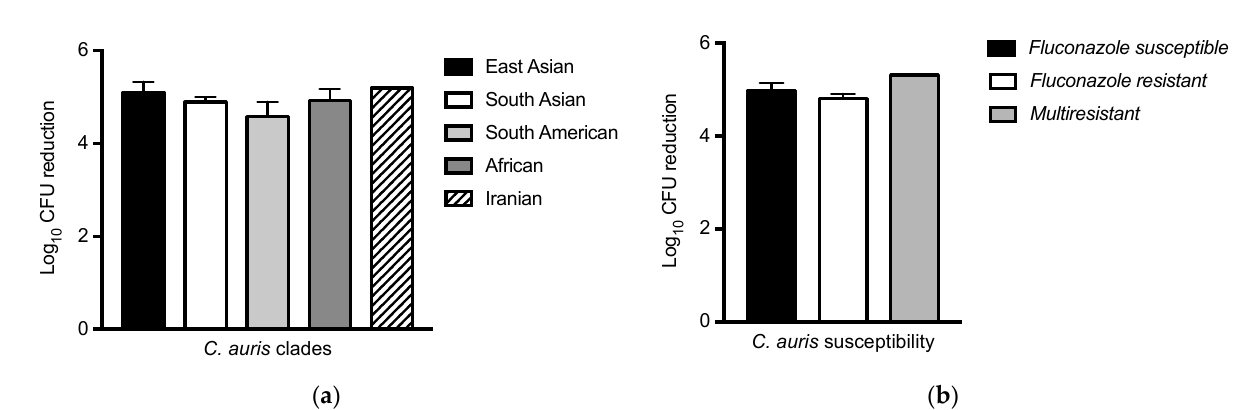
Figure 3. The impact of C. auris traits on antifungal activity of L-Mesitran ® Soft. C. auris isolates with ( a ) different geographic origins, and; ( b ) different antifungal susceptibilities, were incubated with L-Mesitran ® Soft—40%. Multiresistant isolates include those that are resistant to fluconazole and echinocandin and/or amphotericin B. No significant differences were found between groups. Table 1. Overview susceptibility of clinical C. auris isolates with the corresponding mutations.